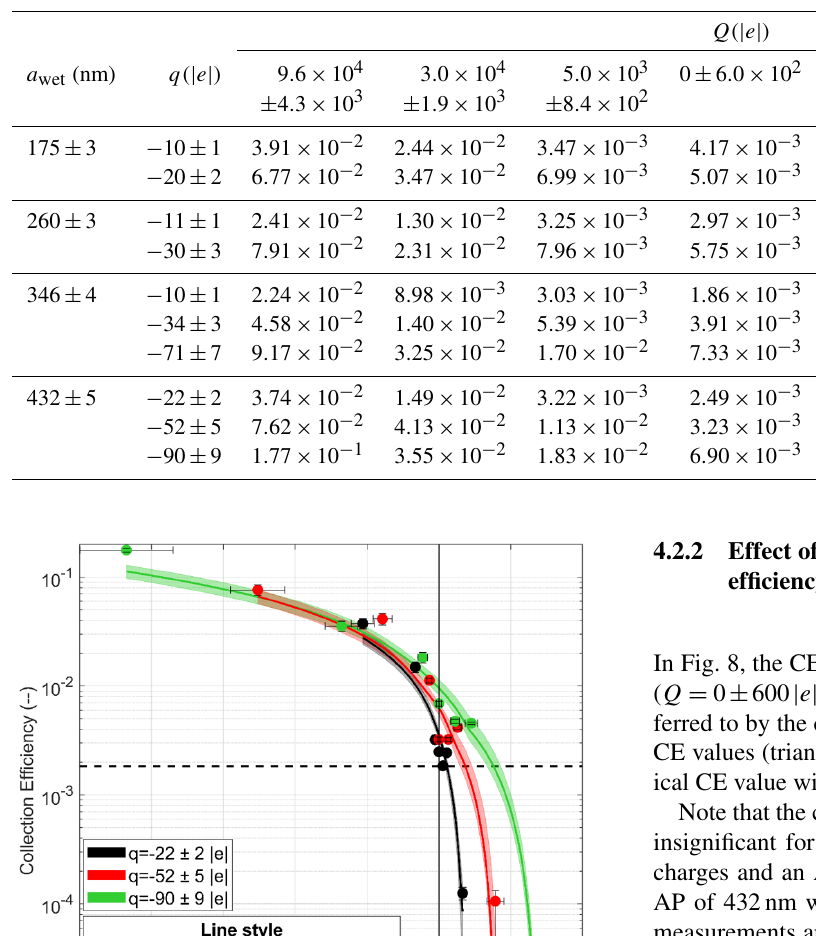
Table 4. CE measurements.